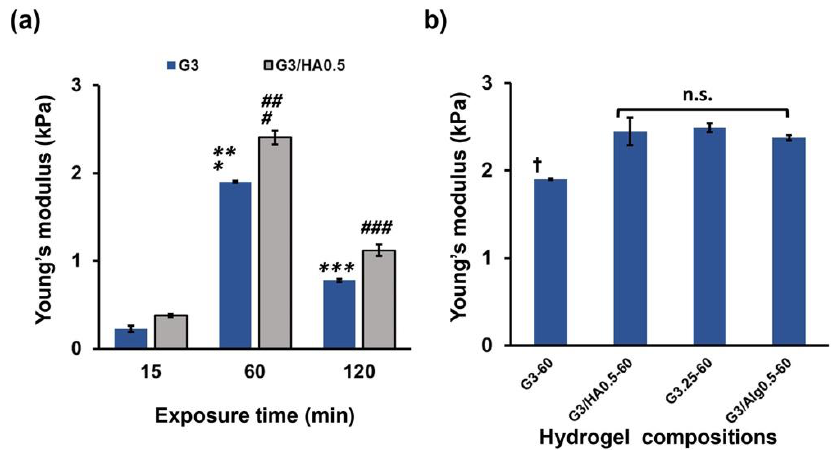
Figure 2. ( a ) Effect of the air containing 16 ppm H 2 O 2 exposure time on the stiffness of G3 and G3/HA0.5 hydrogels. ( b ) Effect of the composition of polymers on the stiffness of hydrogels obtained by applying air containing H 2 O 2 for 60 min. (G3-60, G3/HA0.5-60, G3.25-60, and G3/Alg0.5-60). Bars: S. E. ( n = 3). * p < 0.01, # p < 0.01, 15 min compared to 60 min; ** p < 0.01, ## p < 0.01, 60 min compared to 120 min; *** p < 0.01, ### p < 0.01, 15 min compared to 120 min; † p < 0.01, G30-60 compared to G3/HA0.5-60, G3.25-60, and G3/Alg0.5-60; n.s., p > 0.05. Tukey HSD.